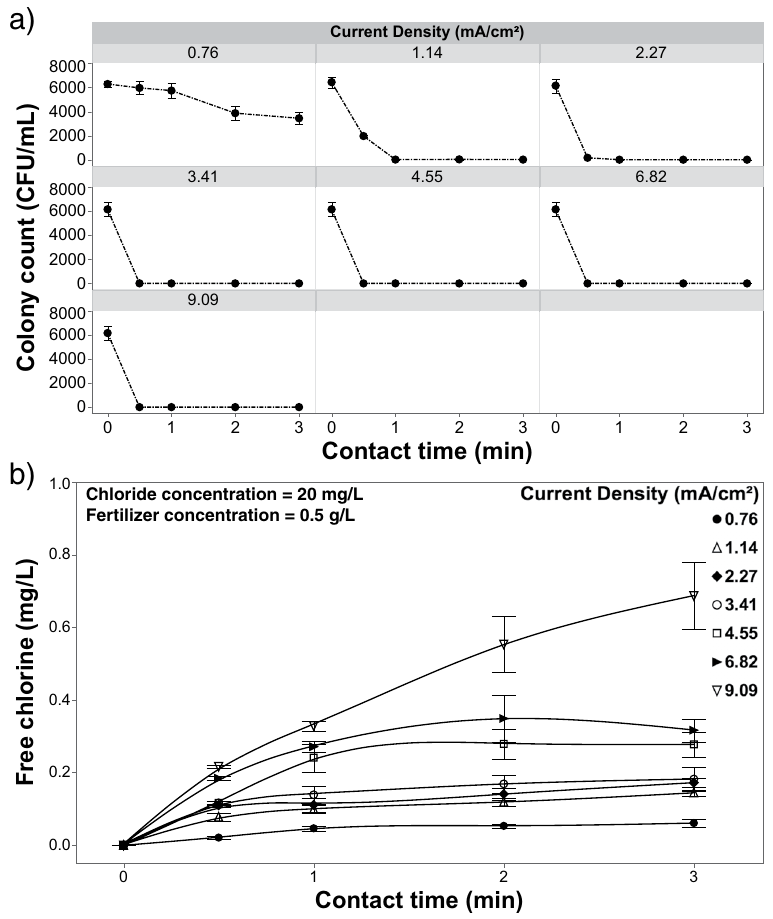
Figure 13. Rhizoctonia solani inactivation and free chlorine dynamics with increasing current density. ( a ) R. solani inactivation as a function of current density and contact time with 20 mg/L of chloride and 0.5 g/L of fertilizer in solution and ( b ) effluent free chlorine from the EFC with applying variable current densities and contact times with the same test solution. Error bars are ± SEM, N =